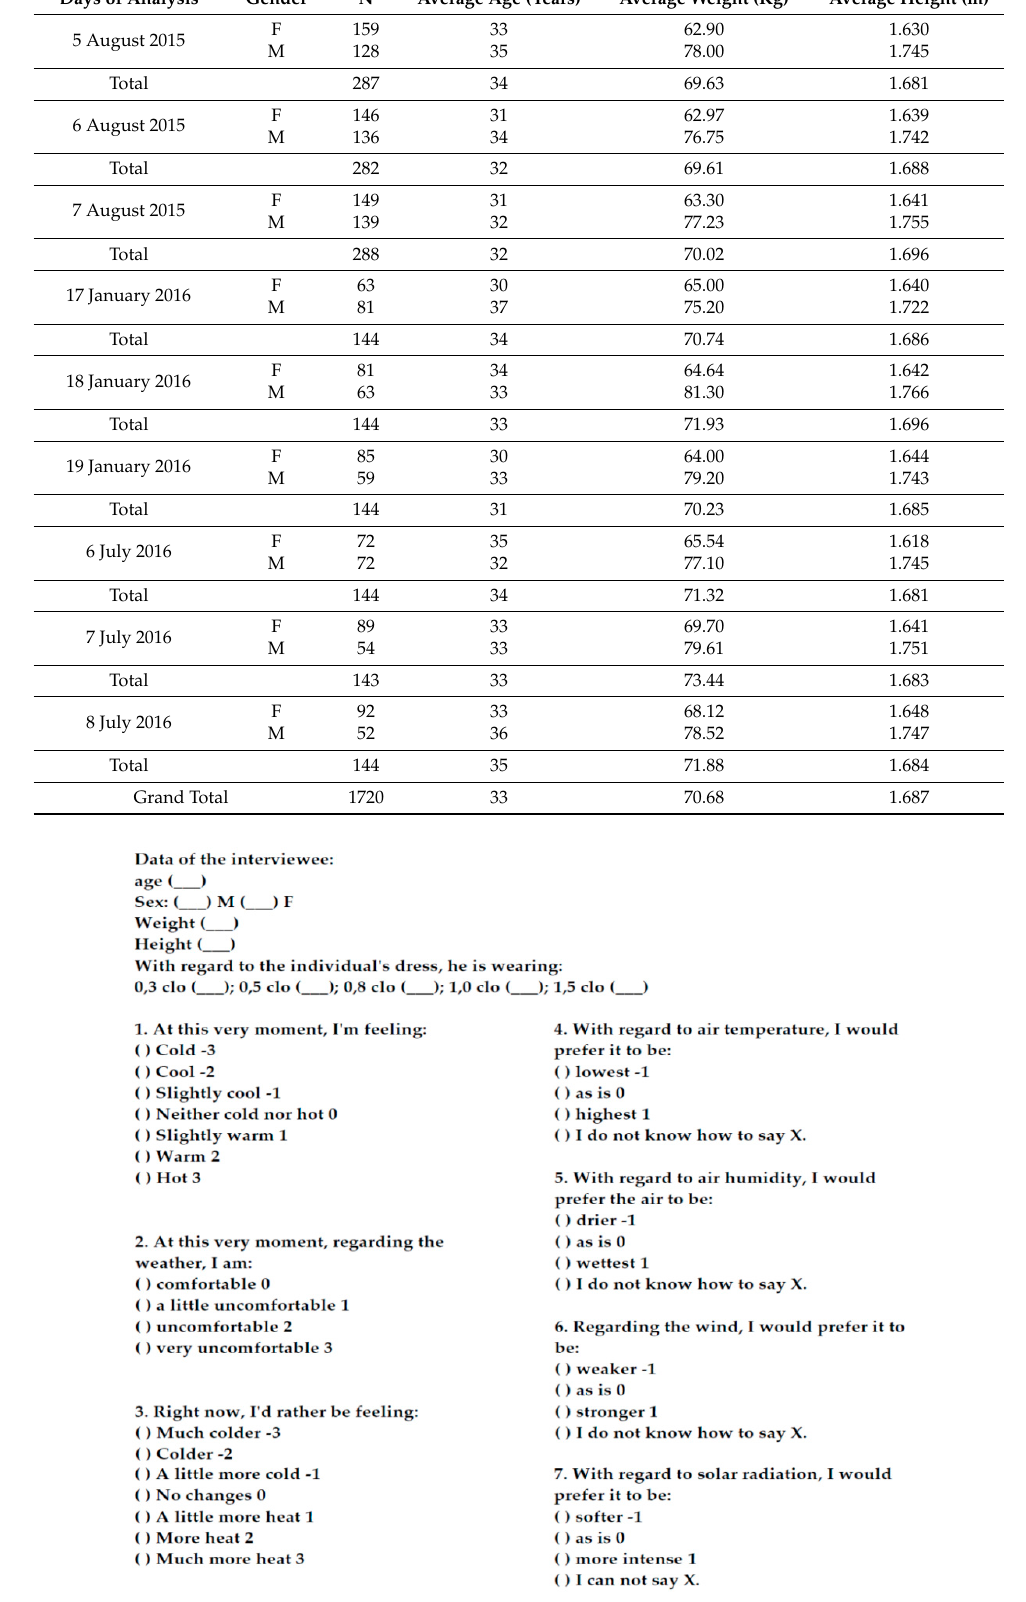
Figure 5. The questionnaire adapted from ISO 10551 (1995).